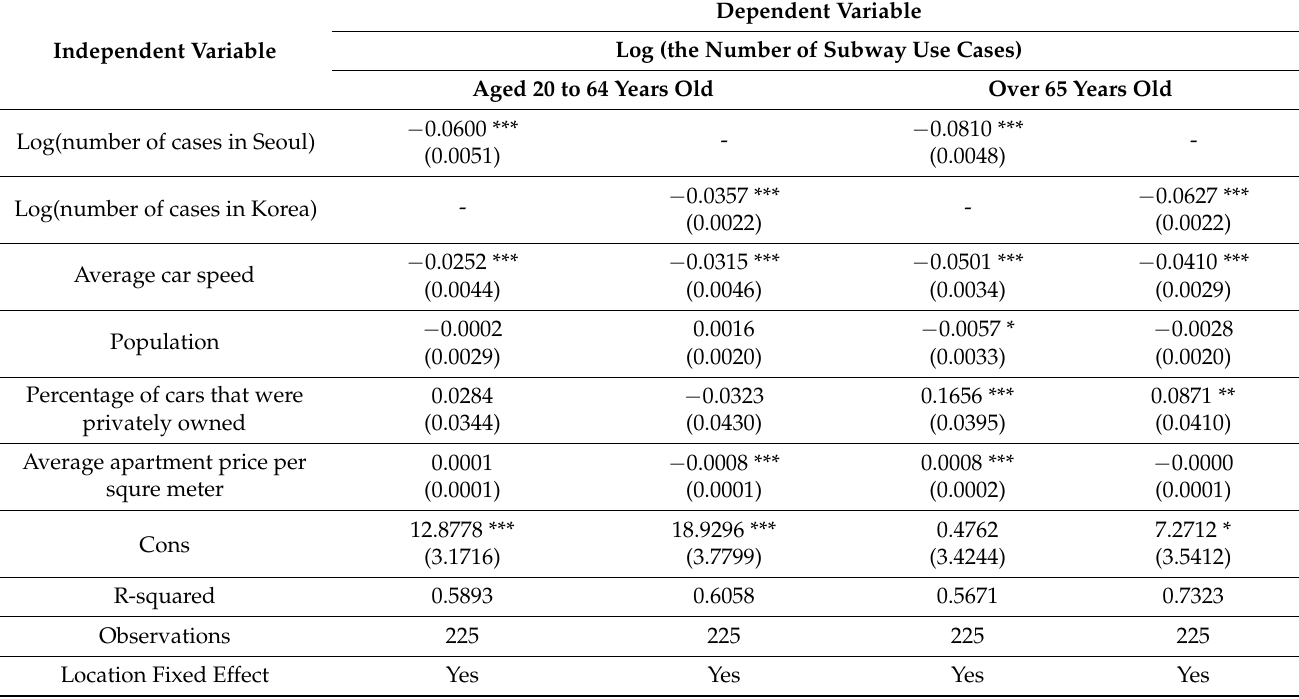
Table 2. Panel results: elasticity of subway use demand by age in response to the number of COVID-19 cases. Dependent Variable Log (the Number of Subway Use Cases) Independent Variable Aged 20 to 64 Years Old Over 65 Years